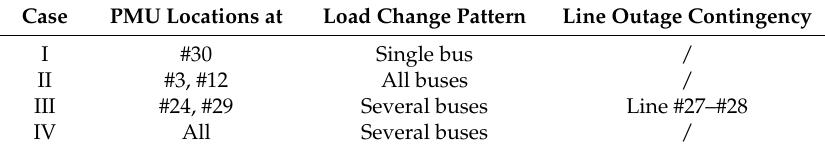
Table 1. Case studies for the IEEE 30-bus system (“#” Indicates” number” & ”/” indicates ”None”).